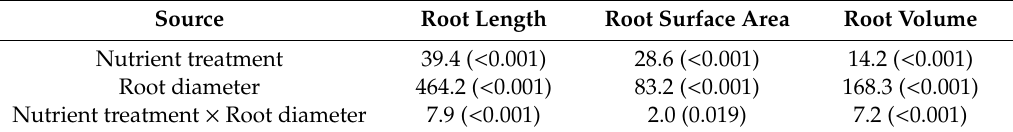
Table 3. F-values and significance ( p -values) of the two-way ANOVA on the effects of nutrient treatment, root diameter, and their interaction on the root length, root surface area, and root volume of the P. chinensis seedlings at final harvest.